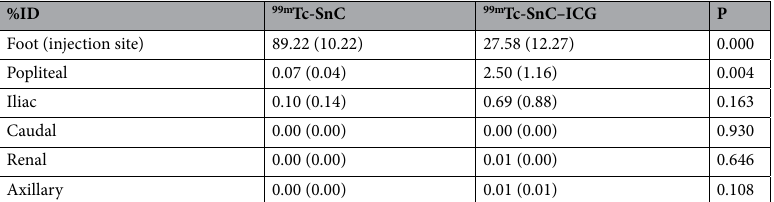
Table 1. Biodistribution of radioactivity using mixed tracer administration in the rat right foot pad. Each value represents mean (SD) of %ID expressed as the percentage of the injected dose per 10 µ L of